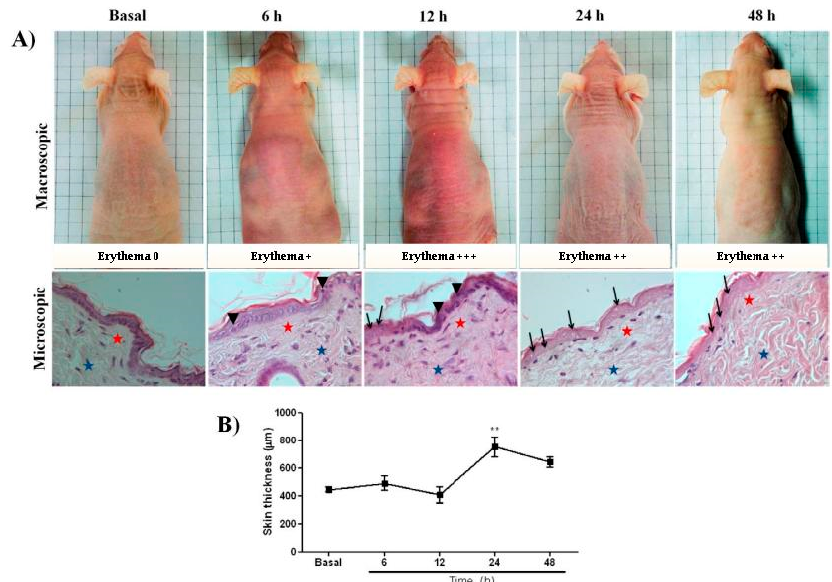
Figure 1. ( A ) Macro- and microscopic changes induced by UVB in skin of hairless mouse. Dorsal skin was exposed to a single UVB dose (2.4 J cm − 1 ) and changes were monitored at various intervals. Skin biopsies were kept in 10% bu ff ered formalin and processed for histopathological examination. Representative photomicrographs using 40 × objective of Haematoxylin-eosin at 6, 12, 24, and 48 h post UV were compared with basal group. Apoptotic cell = arrowhead; enucleated cells = arrows; superficial dermis = red stars; deep dermis = blue stars). ( B ) Morphometric analysis of basal, 6, 12, 24, and 48 h after irradiation. The data represent total skin thickness (10 × objective): mean ± SEM of 6–8 animals in each group (** p < 0.01 di ff erence versus basal, ANOVA, Newman–Keuls post-test).